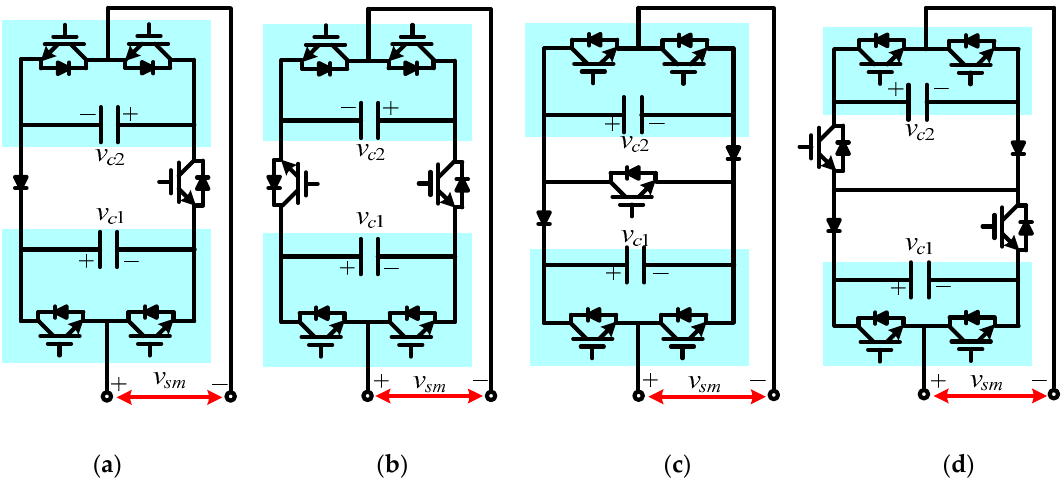
Figure 20. Topology of hybrid sub ‐ modules with DC fault blocking capability. ( a ) SCDSM [61], ( b ) CCDSM [62], ( c ) CDSM [58], ( d ) CCSM [63].